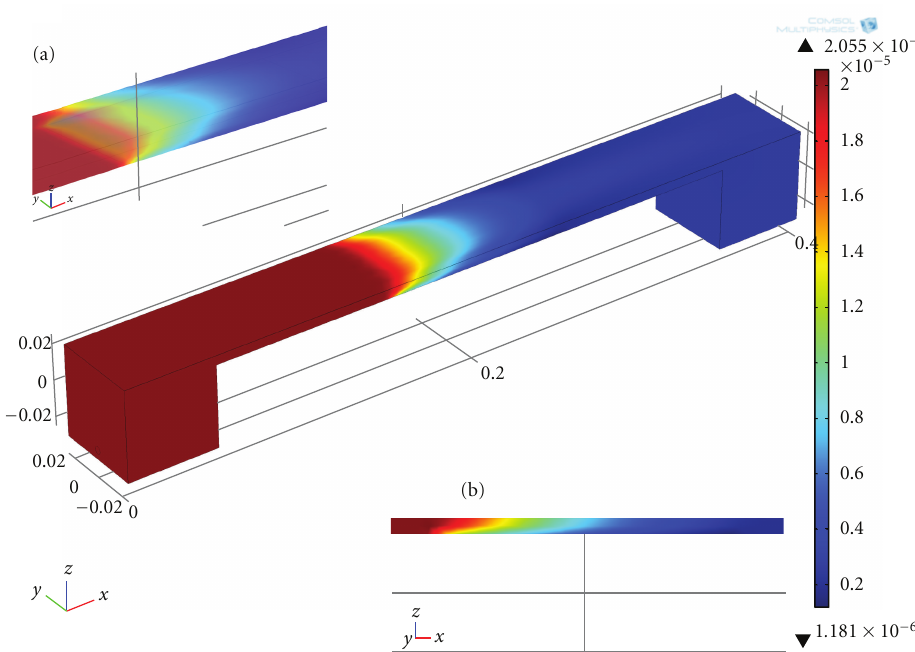
Figure 5: NO x local concentration in the reactor volume, expressed in mol m − 3 ( k app = 4 × 10 − 3 ms − 1 , 32.4 Lh − 1 ). Inset (a), zoom on the photoactive tile; inset (b), xz cross-section of the photoactive tile.